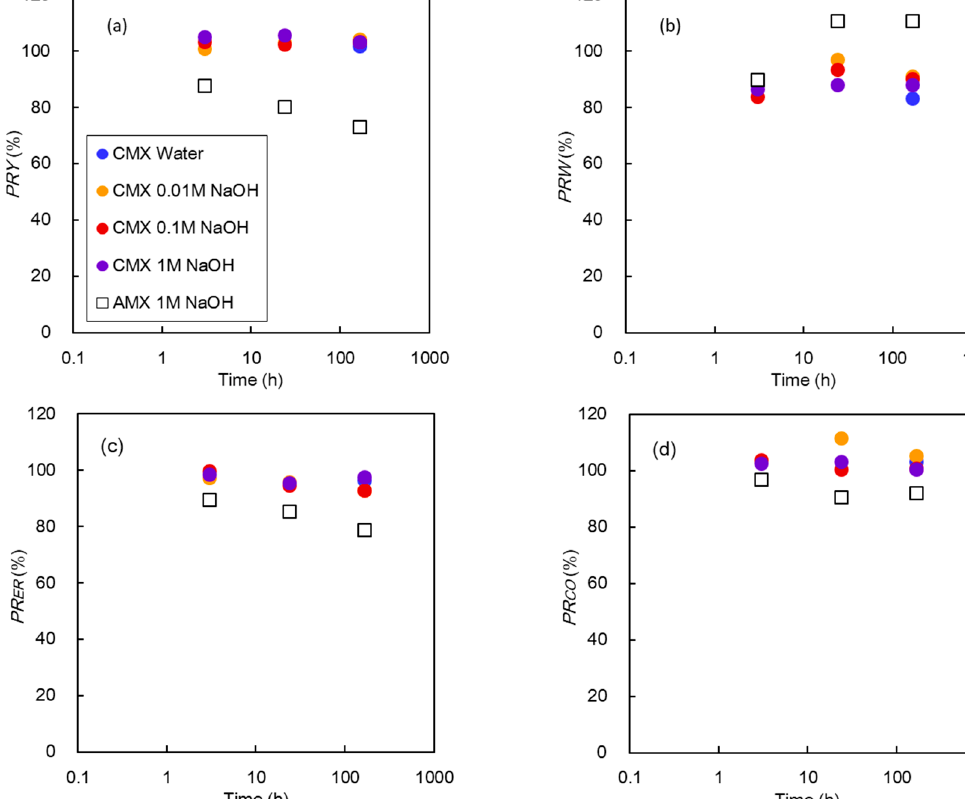
Figure 8. Normalized properties PR of CMX and AMX as a function of varying NaOH concentration and immersion time periods; ( a ): Young’s Modulus PR Y , ( b ): water content PR W , ( c ): electrical resistance PR ER , and ( d ): co-ion rejection PR CO .